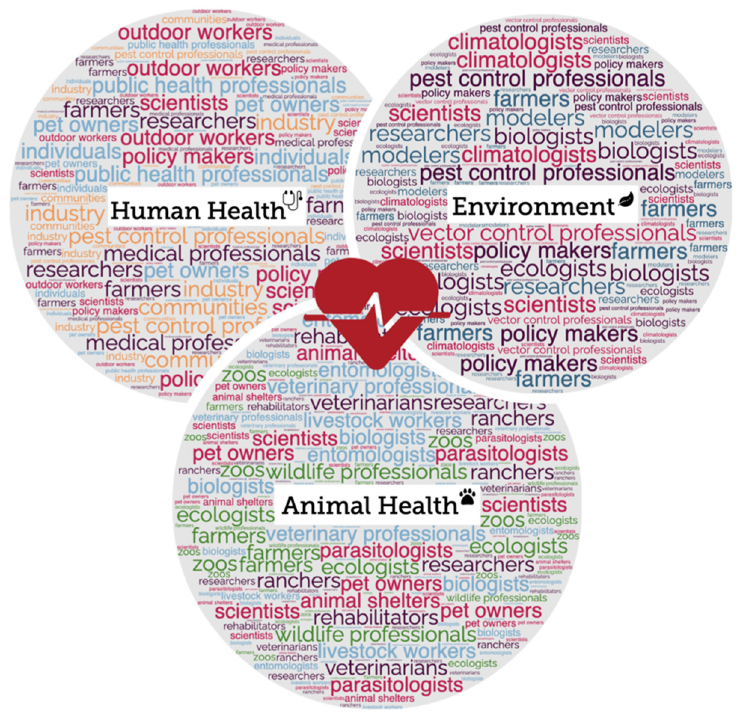
Figure 1. A One Health approach ensures collaboration among the three health sectors—human, animal, and environmental health. Tick control requires collaborative strategies to mitigate disease risk to humans and animals and will require dynamic planning at the agency, community, and individual levels, as highlighted by the examples in this diagram (figure created in the Mind the Graph platform, www.mindthegraph.com, Cactus Communications and Wordclouds.com).